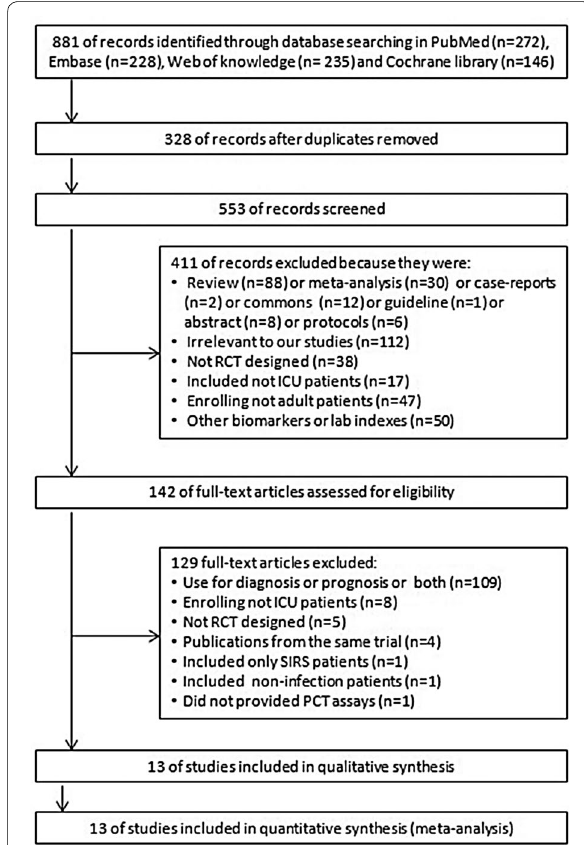
file 3: Table S3. The degree of non-compliance with PCT algorithm recommendations for antibiotics varied